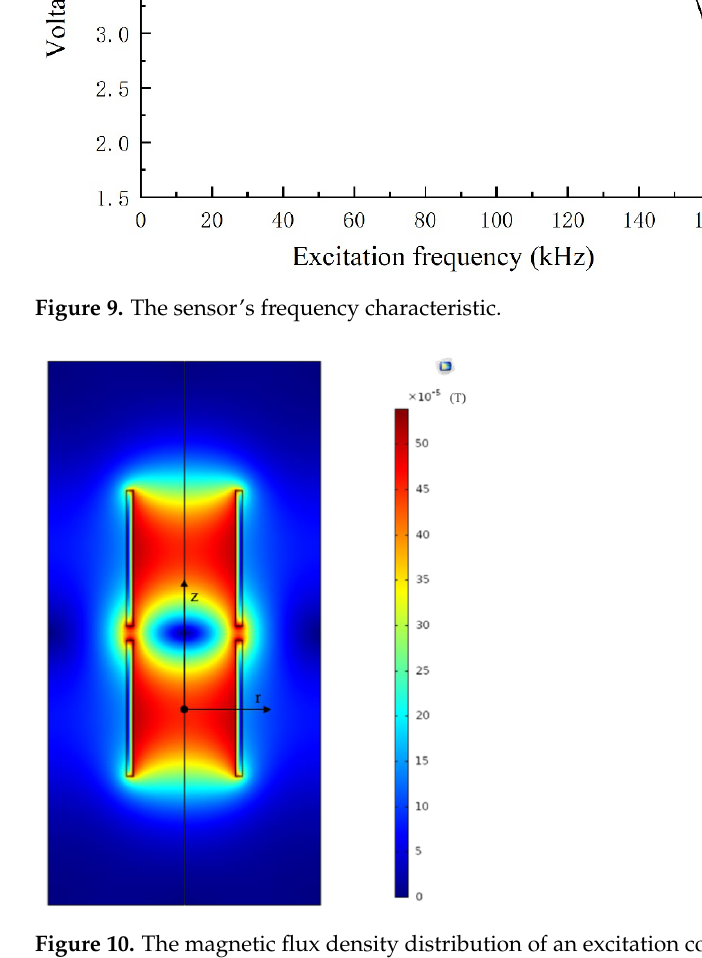
Figure 12. The output voltage relative to r = 0 value when metal debris passes through different radial positions.